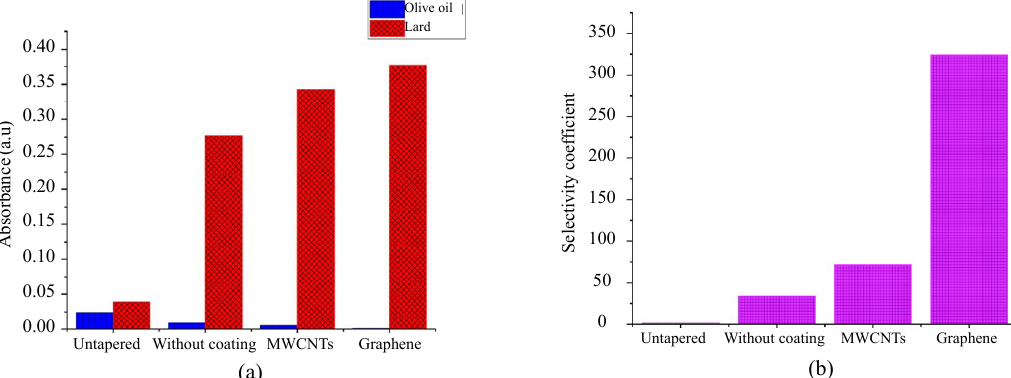
Fig. 4 Properties of tapered POF at 930 nm with different coatings: (a) absorbance of lard and olive oil and (b) selectivity coefficient on the lard substance.